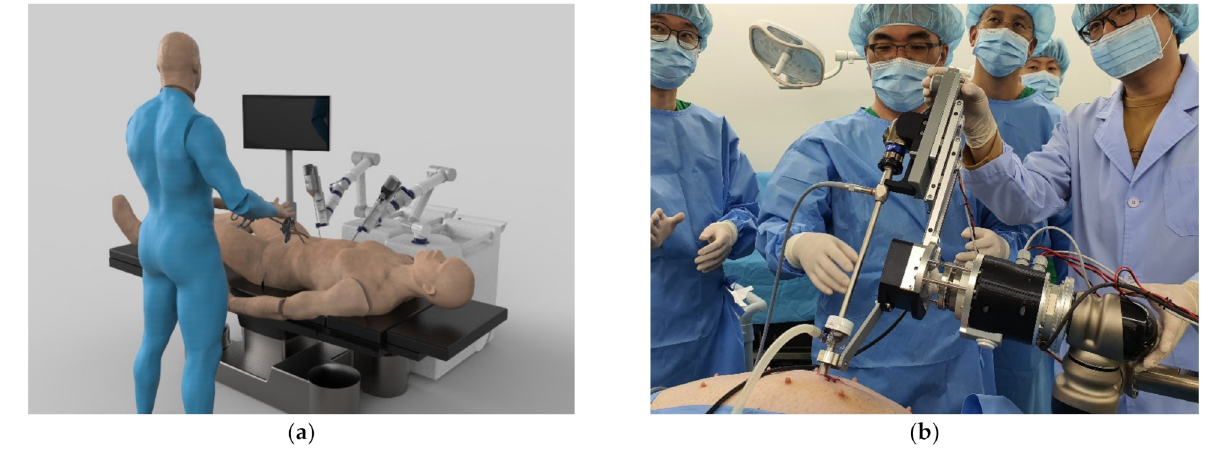
Figure 1. Introduction of the surgical assistant robot: ( a ) conceptual figure; ( b ) animal